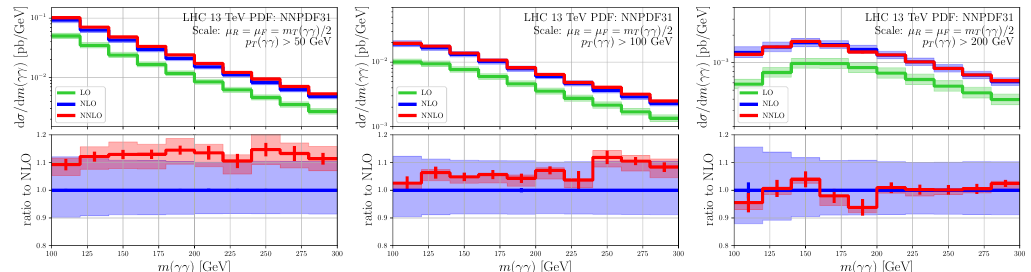
Figure 2 . As in figure 1 but for the m ( γγ ) distribution subjected to different p T ( γγ ) cuts: p T ( γγ ) > 50 GeV (left), p ( γγ ) > 100 GeV (center) and p T